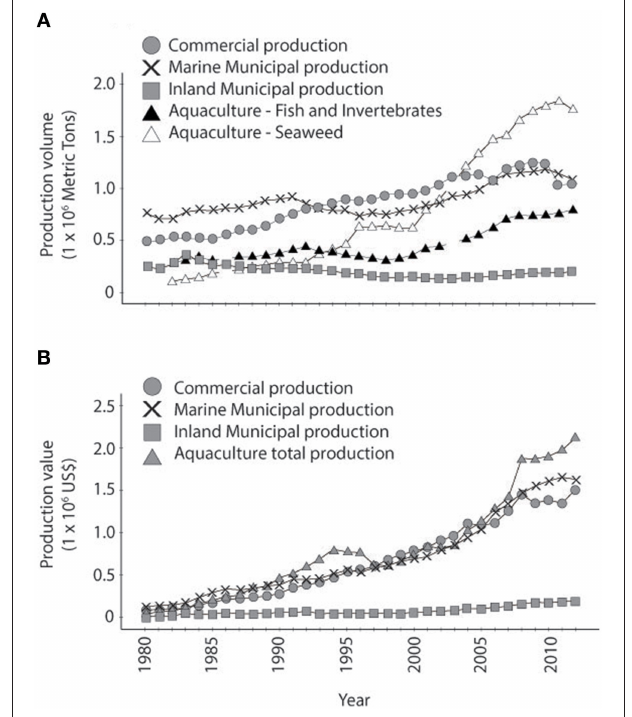
FIGURE 3 | Time-series data of Philippine production volume (A) and value (B) per sector from the years